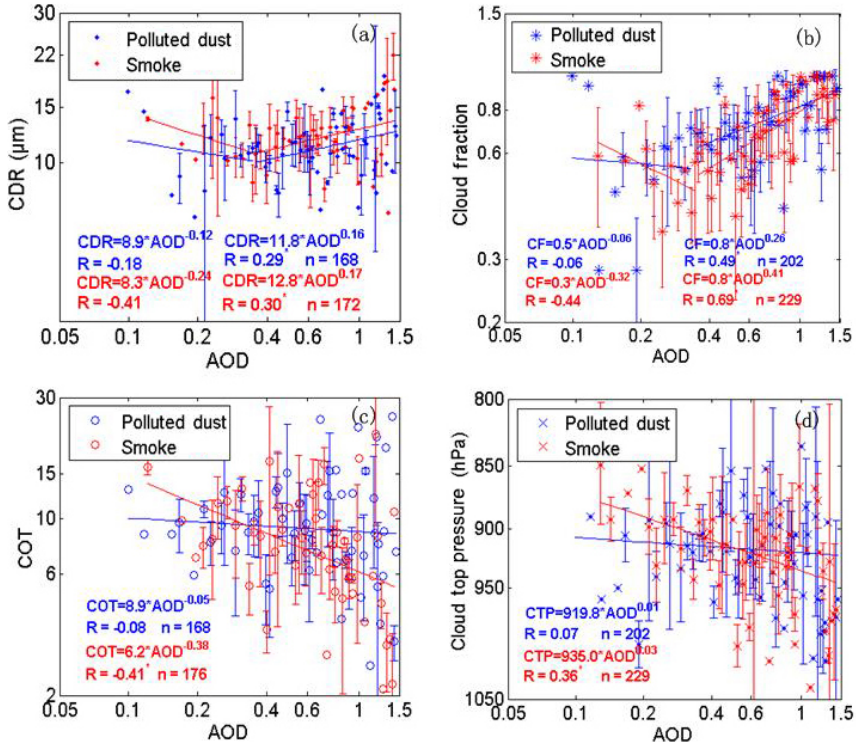
Figure 8. Scatter plots of cloud parameters versus AOD over YRD on log–log scale for cases of mixed-dust-aerosol cloud layers (blue) and mixed-smoke-aerosol cloud layers (red): (a) CDR, (b) CF, (c) COT and (d) CTP. The lines present the least-square fits, and the resulting relations are presented in each figure. The error bars indicate the statistical uncertainties as in Fig.